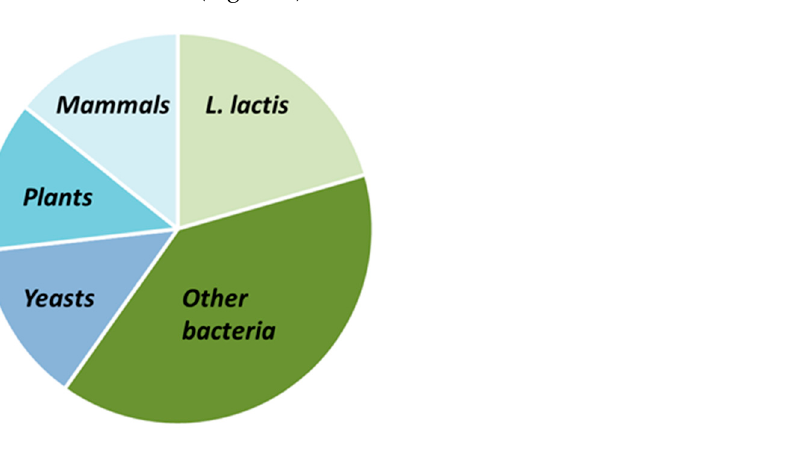
Figure 4. Influence of number of TM helices on expression of MPs expressed in L. lactis . ( a ) On expression of MPs from L. lactis . ( b ) On expression of MPs from other bacteria. ( c ) On expression of eukaryotic MPs. 3.1. Expression of Prokaryotic MPs Tables 2 and 3 report the successful expressions of 23 homologous and 43 heterolo- gous MPs using the NICE system. The expression levels of prokaryotic MPs obtained were the highest of all reviewed MPs, with up to 30% of total MPs (TMP) by heterologous (HorA and MsbA) and homologous (LmrA) expression. The expressed MPs possess up to 13 TM helices, and even with such a high TM helix content, they were produced with expression levels of up to 20% TMP (BcaP and XylP). Most homologous MP expression studies have been focused on proteins belonging to the families of amino acid and ABC (ATP-Binding Cassette) transporters, probably related to the specialization of the labora- tories working with this system. In addition to the above-mentioned amino acid and ABC transporters, other heterologous MPs have been expressed, belonging to diverse families such as cytochrome, permease, and binding proteins (Table 3). The relatively high expres- sion levels obtained with heterologous prokaryotic MPs could be explained by the fact that the codon usage is compatible with the AT-rich codon bias of L. lactis [107]. L. lactis also allowed for the expression of an MP with 14 TM domains, such as the MFS transporter called Rv1410 (Table 3; [85]). 3.2. Expression of Eukaryotic MPs The expression of eukaryotic MPs in L. lactis was initiated and first reported in 2003 by Kunji and collaborators, together with the expression of mitochondrial carriers from yeast [11]. Since then, several other eukaryotic MPs from yeast, plants, and humans have been expressed, with levels from 0.1 to 10% of TMPs (Table 4), mainly from the mitochon- drial carrier superfamily, but also from other families. Only one MP from protozoa ( A. polyphaga ; Table 4; [100]) was expressed in L. lactis . 0